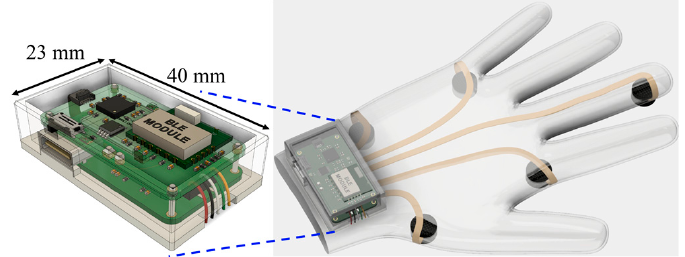
Figure 13. Schematic view of the optimised PCB a tt ached to the proposed textile glove.